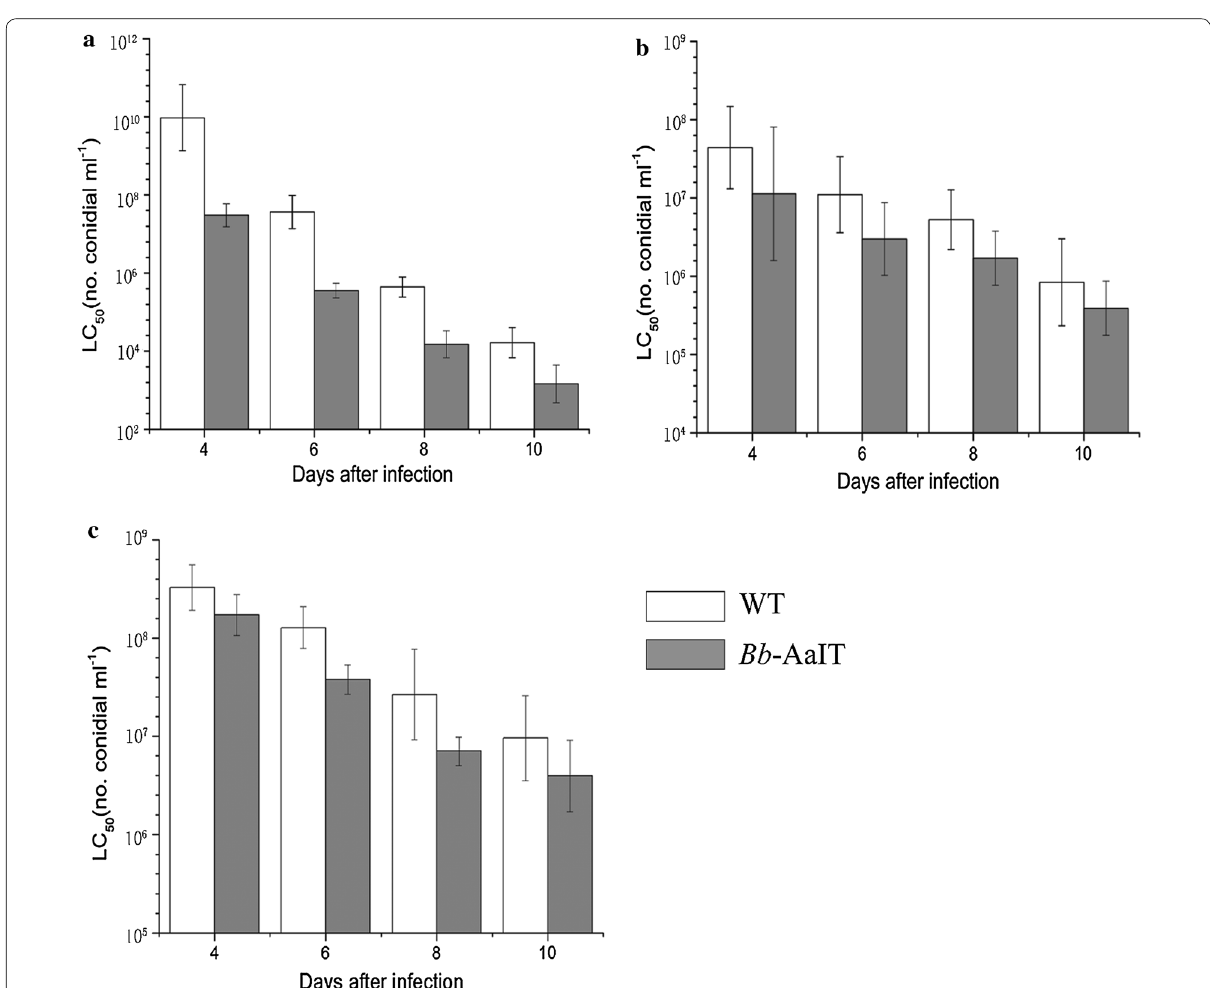
Fig. 3 LC 50 of WT and Bb ‑AaIT strains against larval or adult mosquitoes. Error bars : SE. Three bioassays were conducted to compare the virulence ± of the Bb ‑AaIT and WT strains as follows: a assay 1, the second‑instar larvae of Aedes albopictus infection through conidia ingestion. ( b , c ) 3‑day‑old (3 days after emergence) female adult mosquito infection through cuticle contact ( b , assay 2) or through conidia ingestion ( c , assay